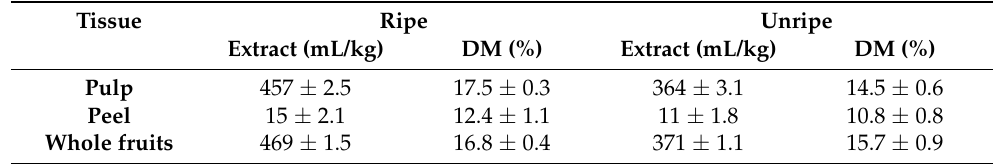
Table 1. Aqueous extract yields from ripe and unripe kiwifruit tissues expressed as mL of obtained juice/kg of kiwifruit and as percentage of dry matter (DM) of the extract. Tissue Ripe Unripe Extract (mL/kg) DM (%) Extract (mL/kg) DM (%) Pulp 457 ± 2.5 Peel Whole fruits 469 ±